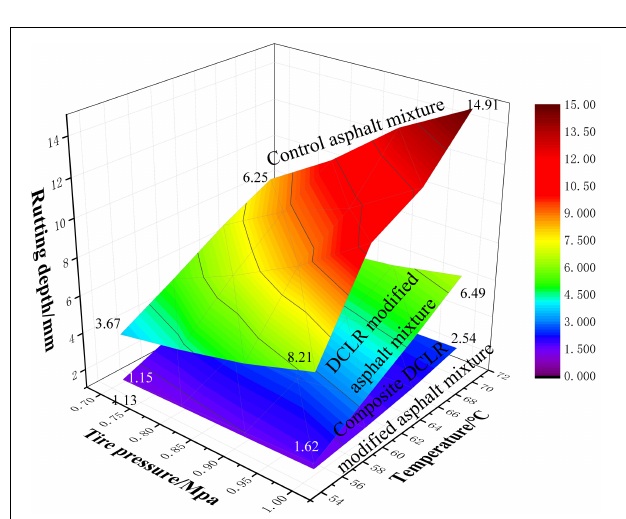
FIGURE 7 | Rutting depths of three asphalt mixtures versus tire pressure and temperature.